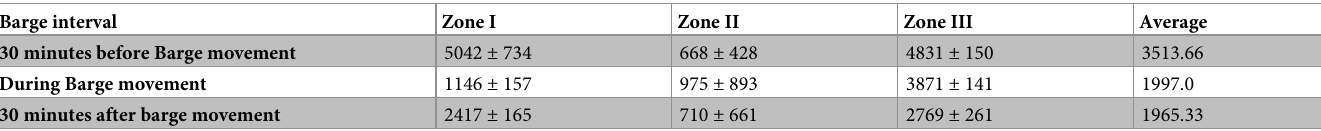
Table 2. Mean abundance of phytoplankton (mean ± SD) in different zones during different time interval. Barge